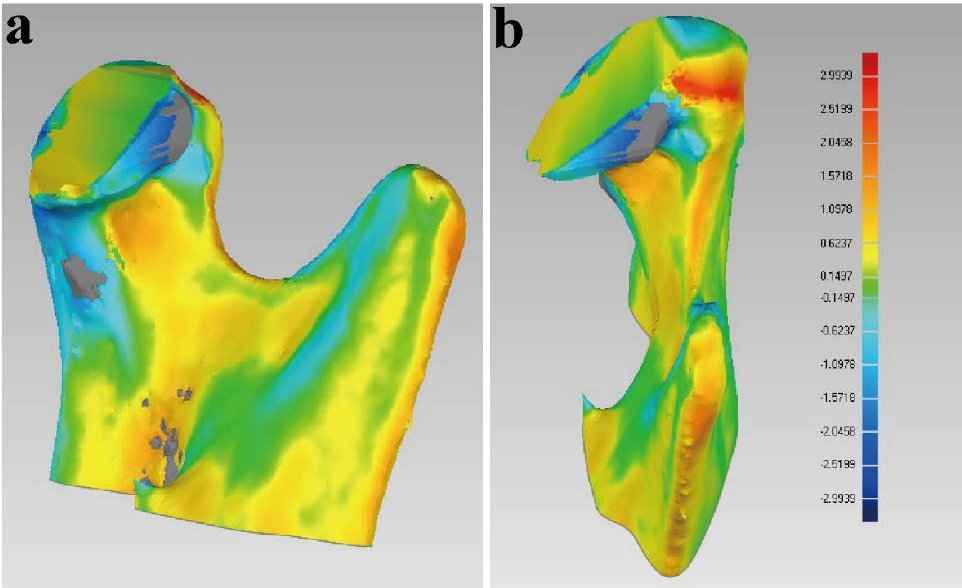
Figure 8. Evaluation of the accuracy of DOS and DOT: (a, b) superimposition of the virtual condylar segment and the postoperative CT scan at 1 week after surgery, for accuracy analysis.